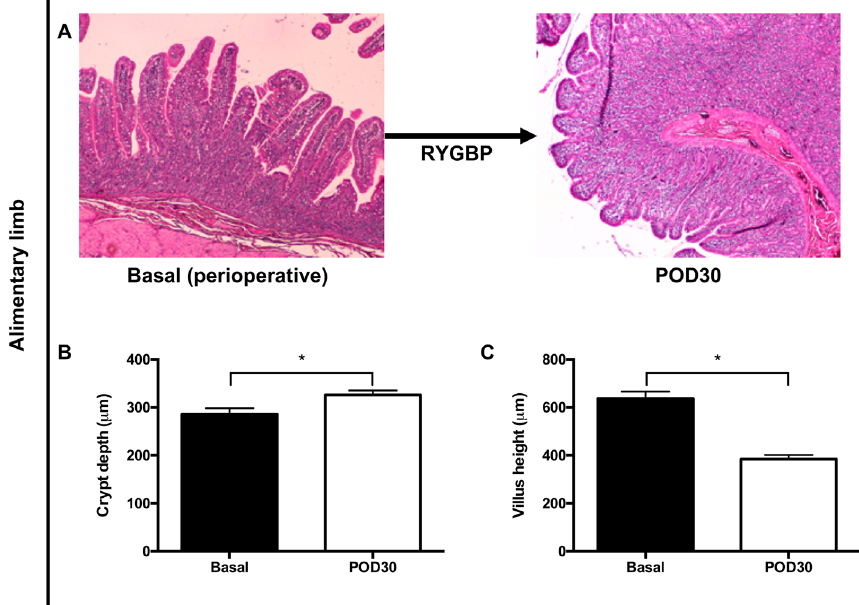
Figure 4. Remodeling of the alimentary limb before (preoperative) and after surgery at postoperative day (POD) 30 in the RYGBP group ( A ). Changes in crypt depth ( B ) and villus height ( C ). All values are expressed as mean ± SEM . * p < 0.05. RYGBP Roux-en-Y gastric bypass